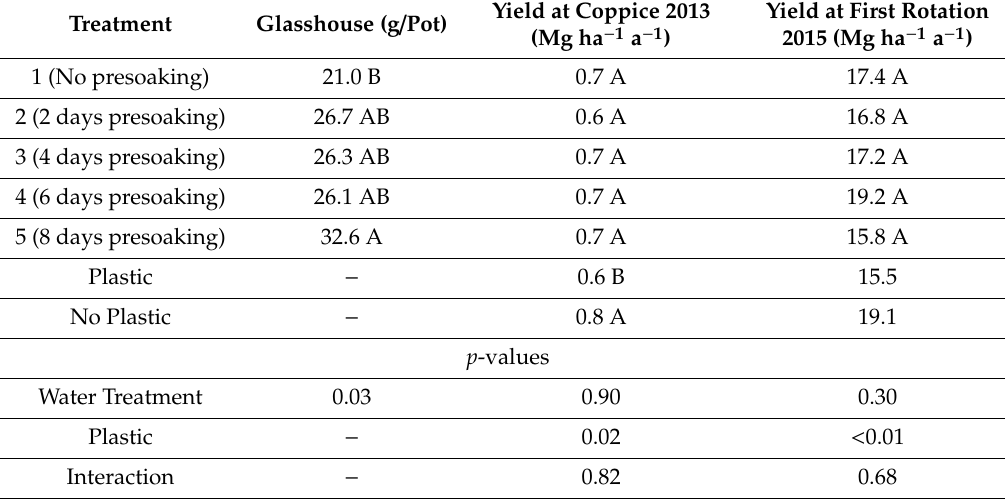
Table 3. Results from pre-soaking and plastic application from initial glasshouse investigation and results from field trials planted in 2013 and harvested after one growing season and then after two years growth (three-year-old roots). All weights are expressed on a dry matter basis. Pairwise di ff erences between treatments ( p = 0.05) were compared using Tukey’s test. Numbers followed by the same letter are not statistically di ff